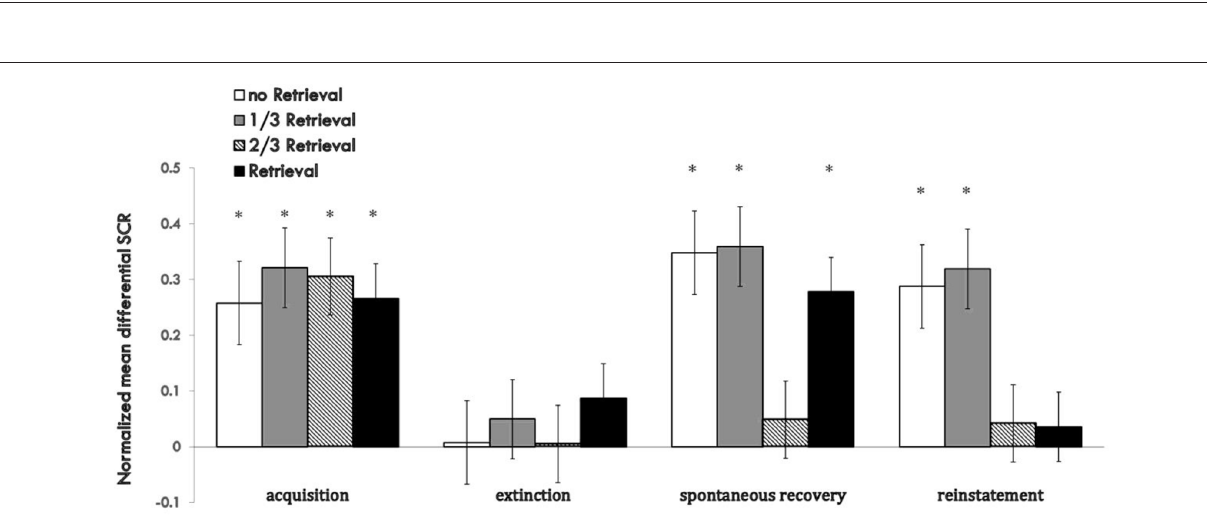
FIGURE 4 | Mean differential SCRs to the last trial of re-extinction and first trial of reinstatement in each group. The ∗ represent p < 0.05. Error bars represent standard errors.